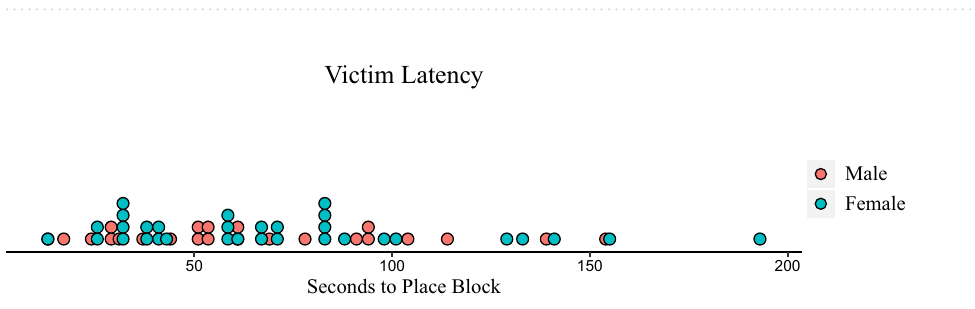
Table 2. Raw means (and SE) of two overall weighted empathy measures for female and male bystanders by condition.